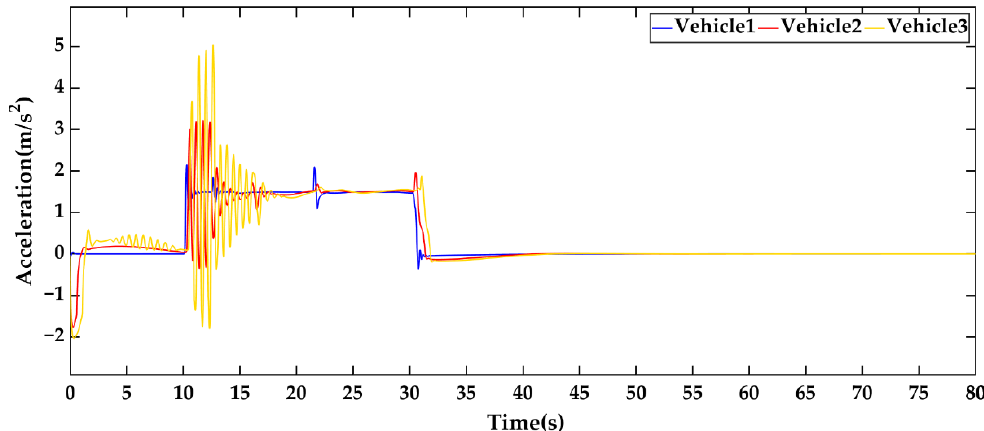
Figure 10. The velocities of the following vehicle under the improved MPC strategy in Scenario 1.